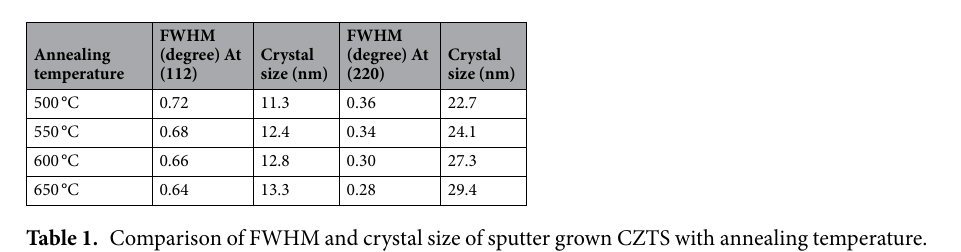
Figure 4. XRD pattern of CZTS layer after annealed at different temperatures.